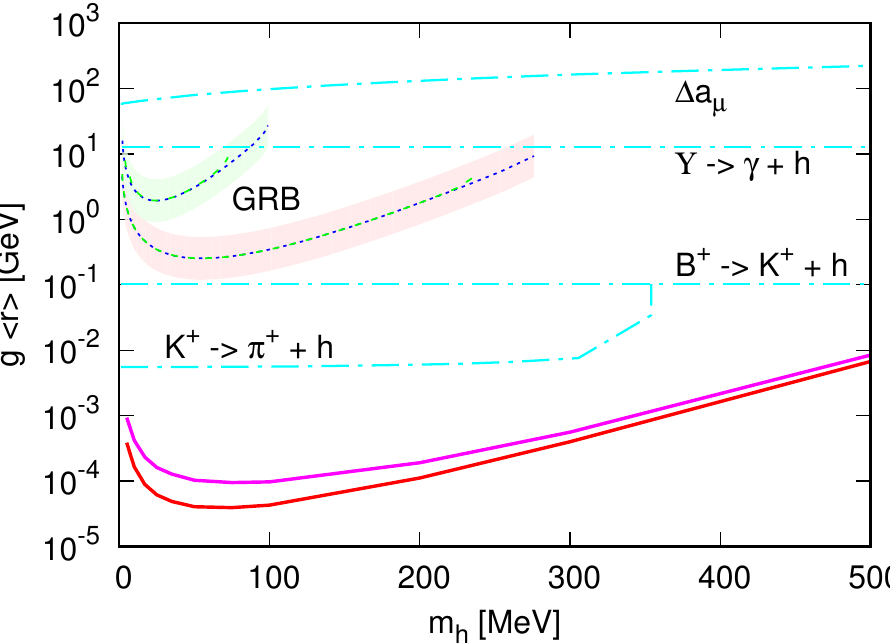
Figure 9 . SN 1987A upper limits on g h r i , the product of the Higgs portal coupling with the vacuum expectation value of the radial (cid:12)eld r , for various light Higgs boson mass m h (solid lines). The upper solid curve is derived by using the SP07 global (cid:12)ts for the nucleon-nucleon elastic scattering cross section in the energy loss rate calculation, and the lower one by using the one-pion exchange (OPE) approximation. Also shown are the upper limits set by laboratory experiments (dash-dotted lines, from top to bottom), such as the muon anomalous magnetic moment (cid:1) a (cid:22) , radiative Upsilon decays (cid:7)( ns ) ! (cid:13) + h , B meson invisible decay B + ! K + + h , as well as K meson invisible decay K + ! (cid:25) + + h . The dotted and the dashed lines labelled \GRB" are the upper limits we derived in ref. [37] by invoking the energy loss argument on the initial (cid:12)reballs of gamma-ray bursts. Two GRB initial (cid:12)reball temperatures values T 0 = 18 MeV (lower) and 8 MeV (upper) are assumed, and the Higgs portal coupling g is taken to saturate the current collider bound (dotted) and at future collider sensitivities (dashed). The uncertainties in these GRB upper limits resulting from the error in the GRB energy loss argument, eq. (5.4), are indicated by the (cid:12)lled